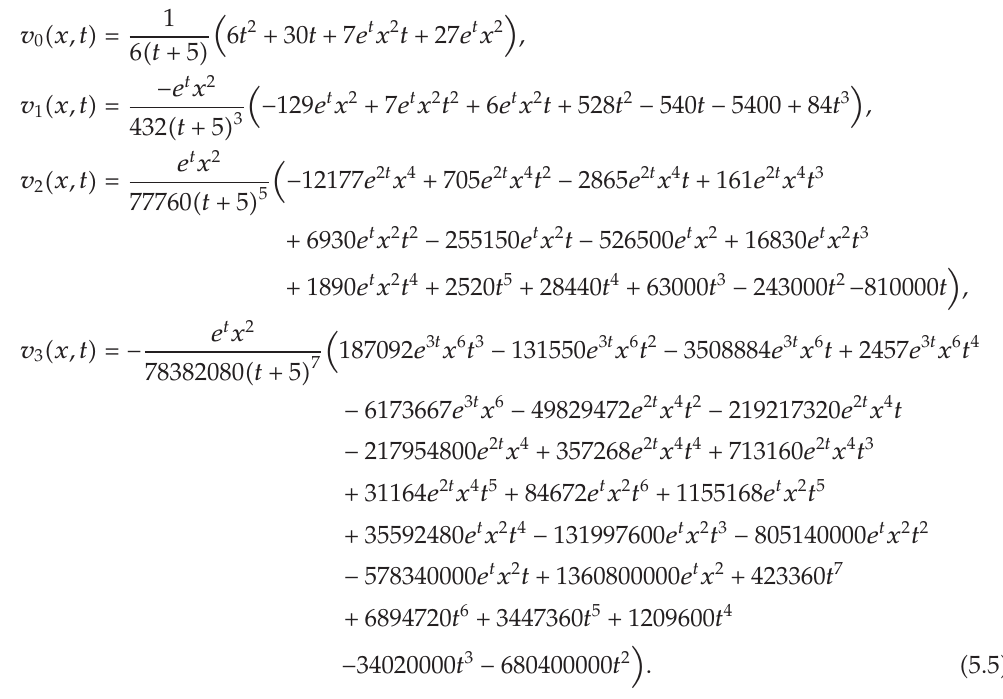
The exact solution, approximate solution, absolute error, relative error, L 2 -norm error, maximum absolute error, and maximum relative error at some time levels are presented in Tables 1 and